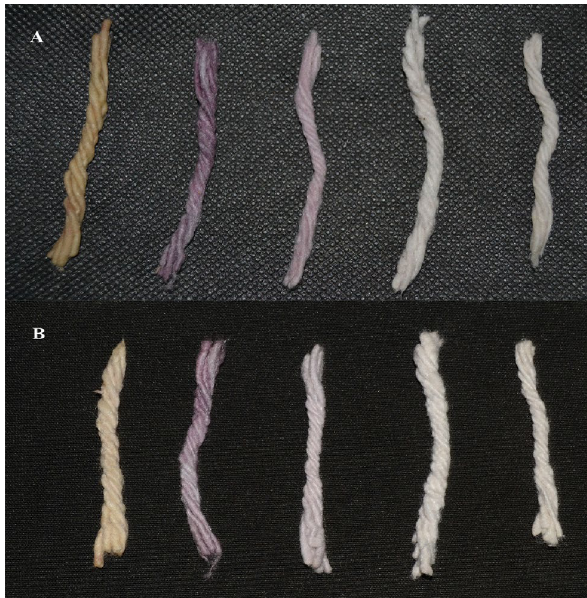
Figure 9. ( A ) cotton material dyed using gold nanoparticle colloid solution, ( B ) cotton material after exposure to various stress